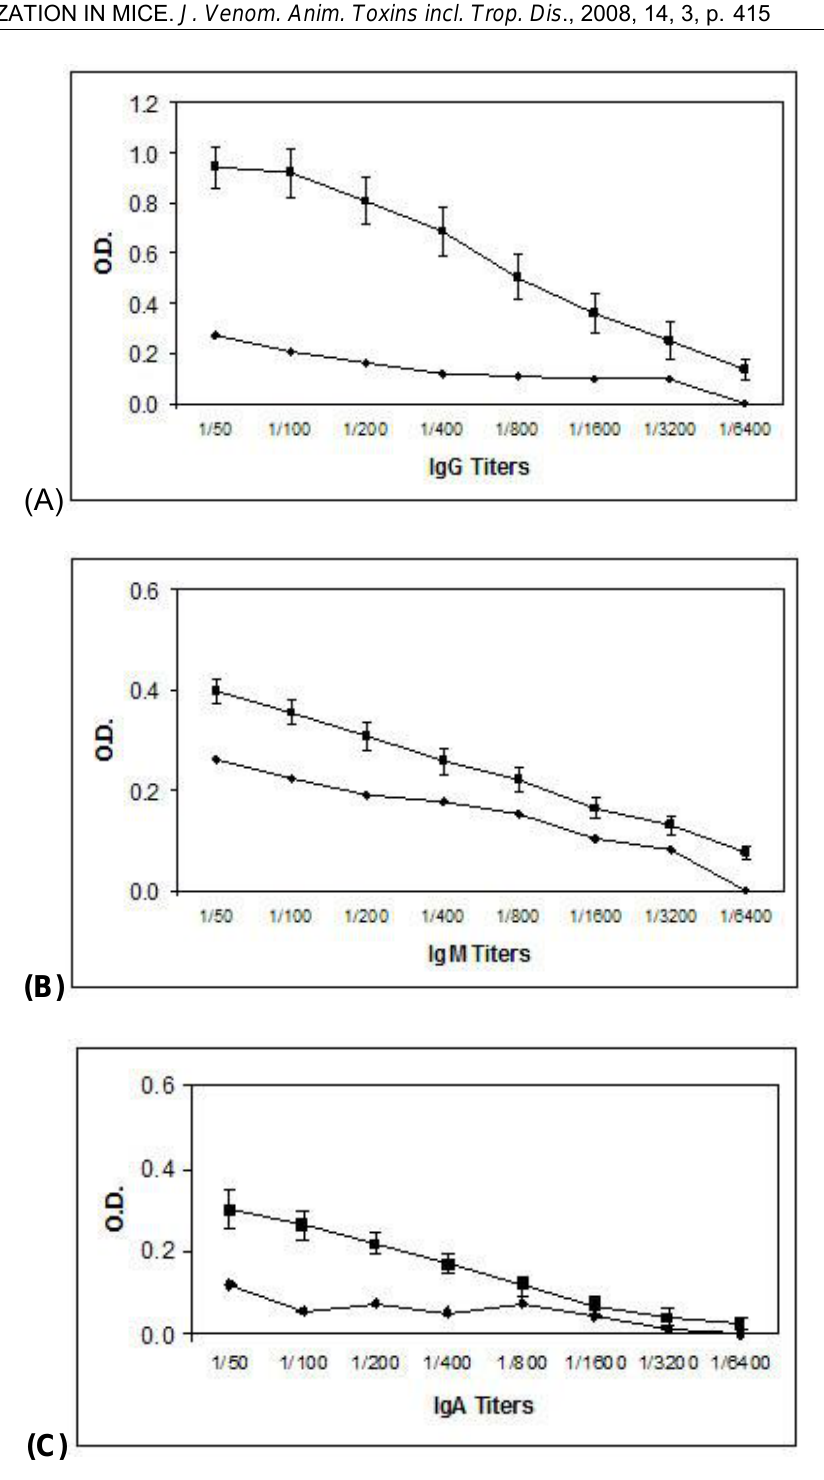
Figure 2. Detection of IgG (A), IgM (B) and IgA (C) antibodies against T. mentagrophytes antigens in hyperimmunized Swiss mice. ■ = immunized animals (data are reported as means ± SE); ▲ =